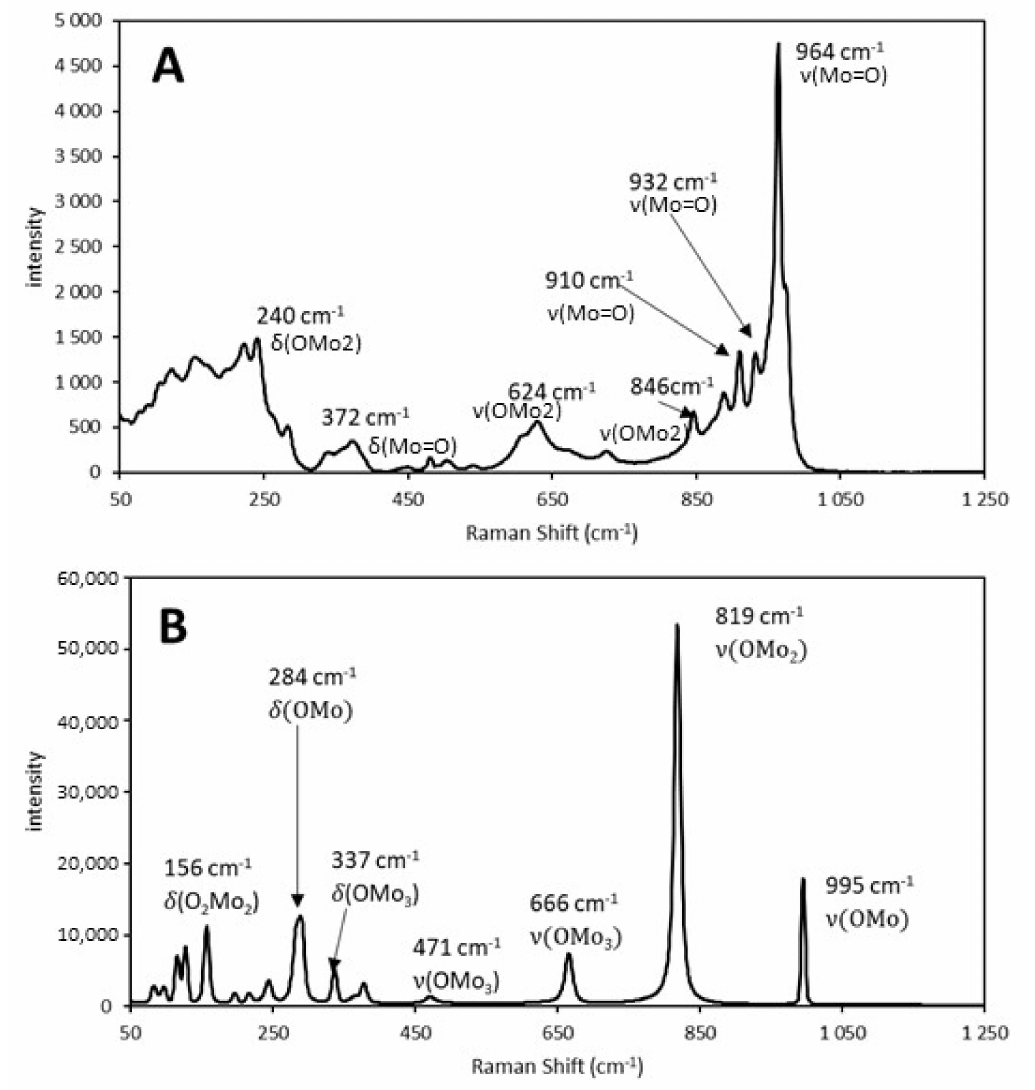
Figure 1. Raman spectra of the Mo-supported mesoporous silica catalyst with a Mo content of 38 wt% ( A ) before calcination (ammonium heptamolybdate) and ( B ) after calcination at 500 ◦ C for 4 h (molybdenum (VI) oxide). A 532 nm laser was used to excite the samples. Here, δ and ν denote bending and stretching vibrations, respectively